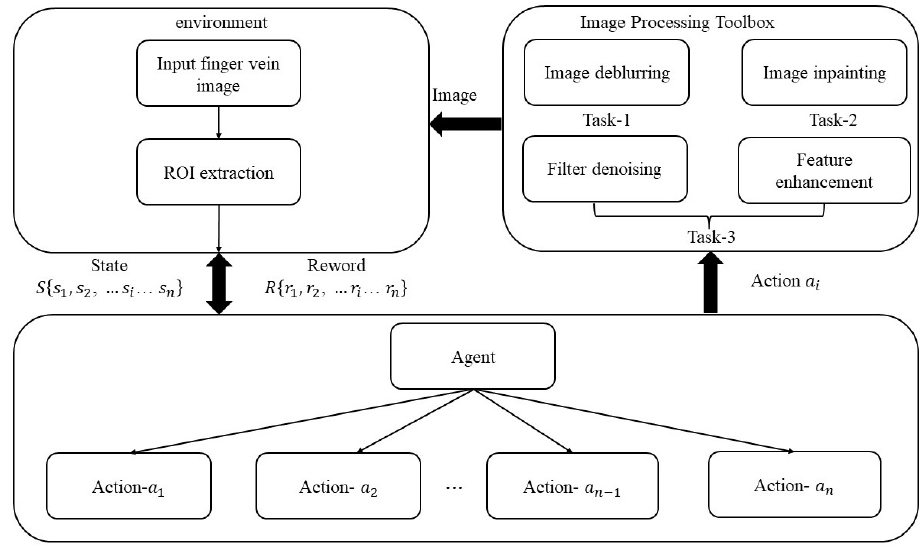
Figure 2. The overall flowchart of the proposed method: